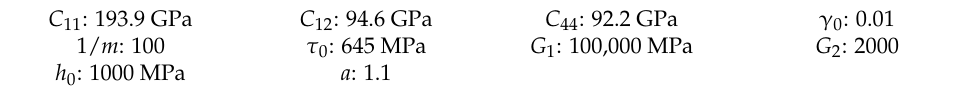
Table 4. CP model fitting parameters